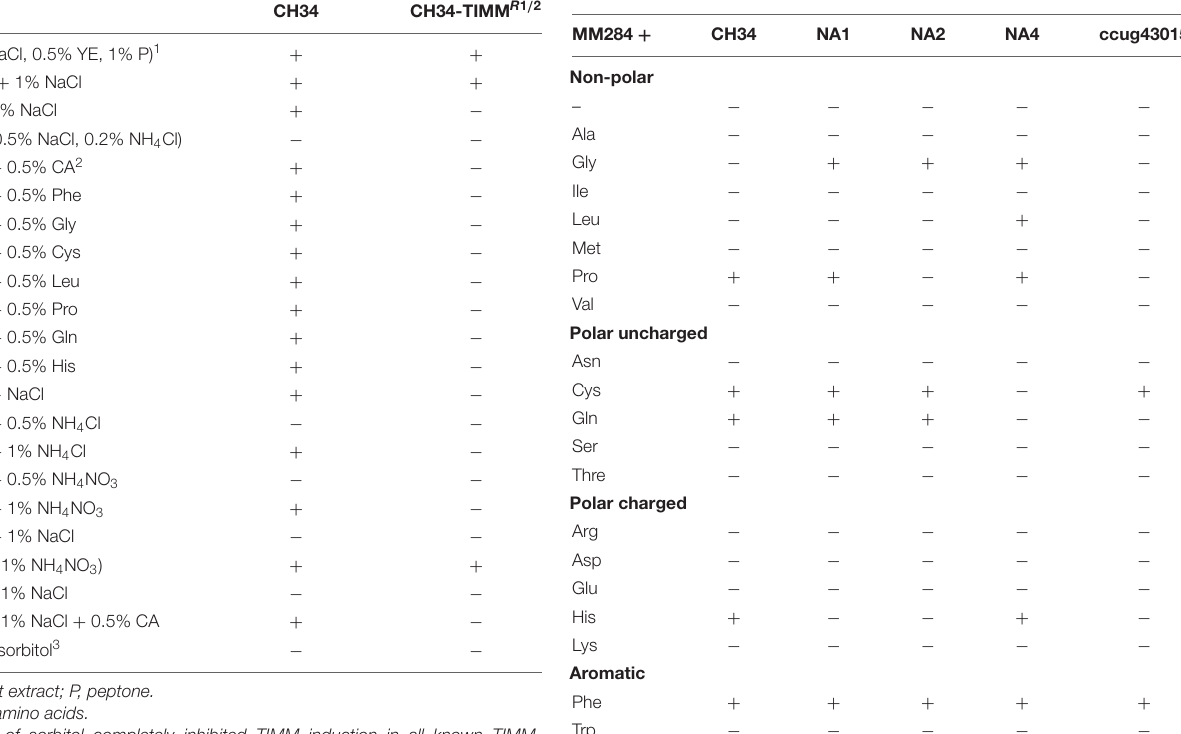
TABLE 4 | Effect of supplementing a specific amino acid to MM284 at a final concentration of 0.5% (w/v) on TIMM induction for different C. metallidurans strains ( + for induction and − for no induction) as determined by the ratio of viable count at 37 to 30 ◦